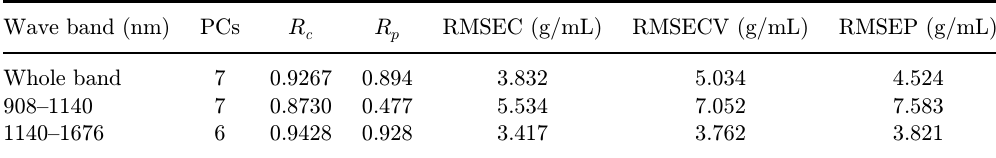
Table 4. Results before and after elimination of insigni¯cant waveband.